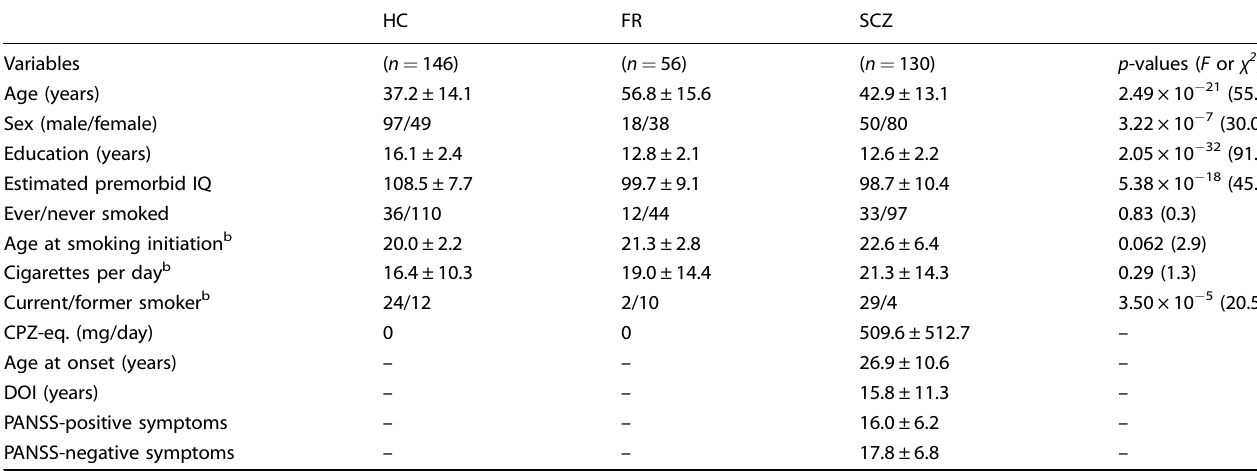
Table 2. Demographic information for the Japanese target GWAS sample with